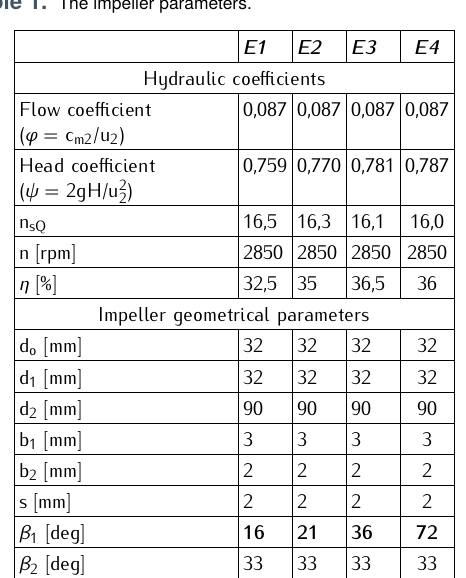
Table 1. The impeller